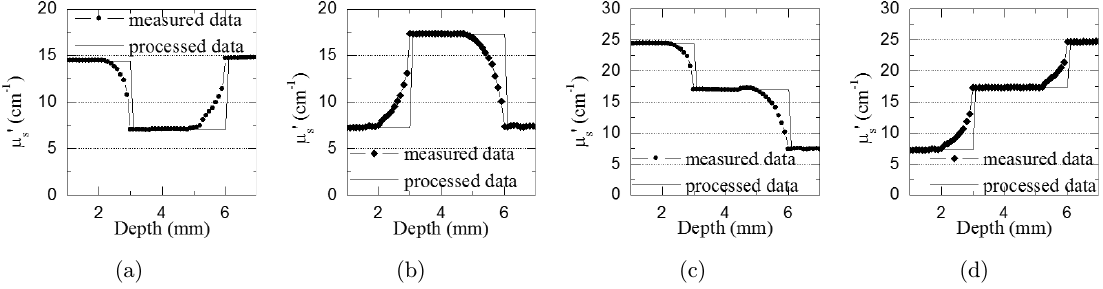
Fig. 8. The (cid:1) 0 s curves of three-layer group L (a) Lbdb model (b) Lbub model (c) Lbdd model (d) Lbuu model.